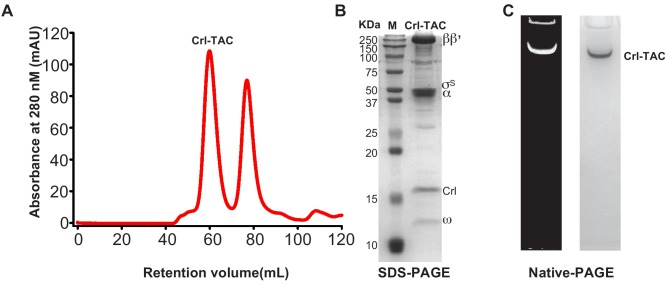
The preparation of E. coli Crl–TAC complex.(A) Elution peaks of E. coli Crl–TAC from a size-exclusion column. (B) SDS-PAGE and (C) native-PAGE of the E. coli Crl–AC. The gel was first stained with SYBR Gold for nucleic acids and then with Coomassie Brilliant Blue for proteins.